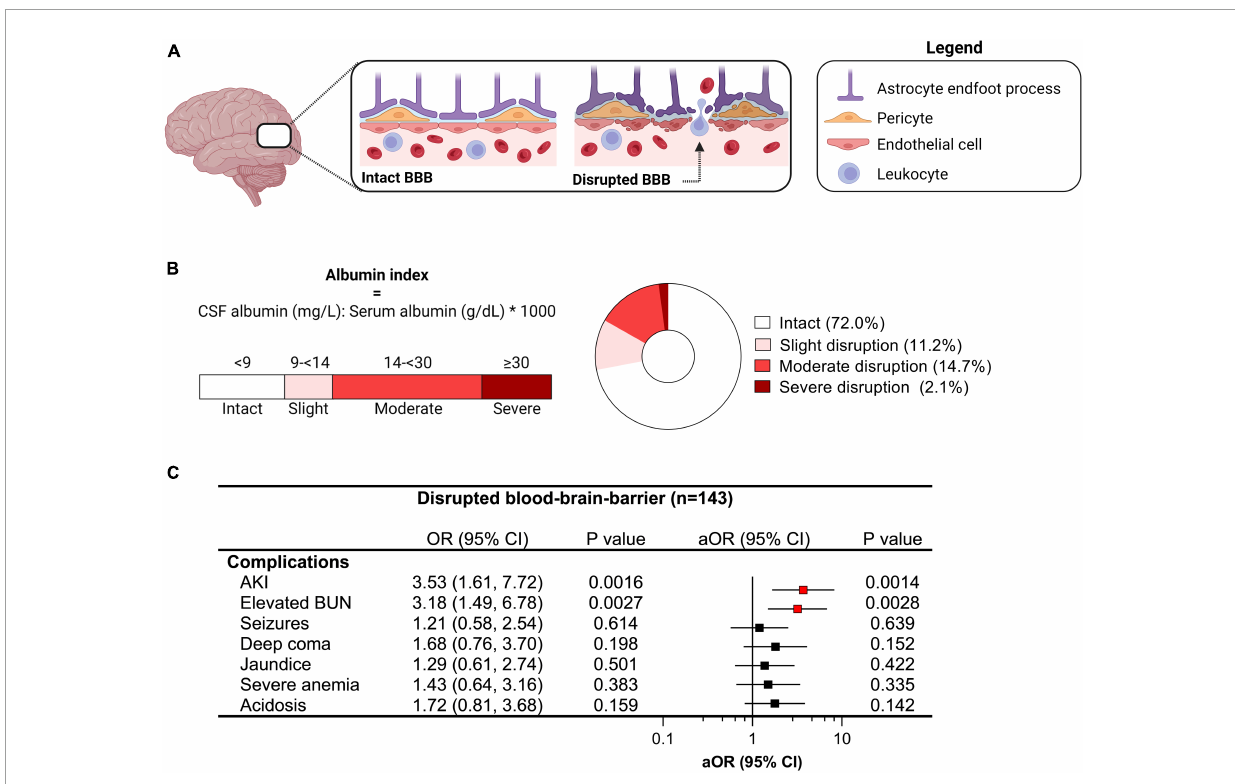
FIGURE2 Relationship between clinical complications and blood-brain-barrier (BBB) disruption in cerebral malaria. (A) Diagram showing an intact and disrupted BBB characterized by increased permeability and extravasation of immune and red blood cells into the brain parenchyma due to endothelial activation. (B) BBB integrity was assessed using the albumin index comparing albumin levels in the cerebrospinal fluid (CSF) and plasma where the degree of BBB disruption can be quantified and categorized using established cut-offs. (C) Forest plot depicting the odds ratio (OR) and 95% confidence interval (CI) from logistic models were used to evaluate the relationship between clinical complications and BBB disruption (any) with adjusted OR (aOR) adjusting for age and sex. Significant relationships are depicted in